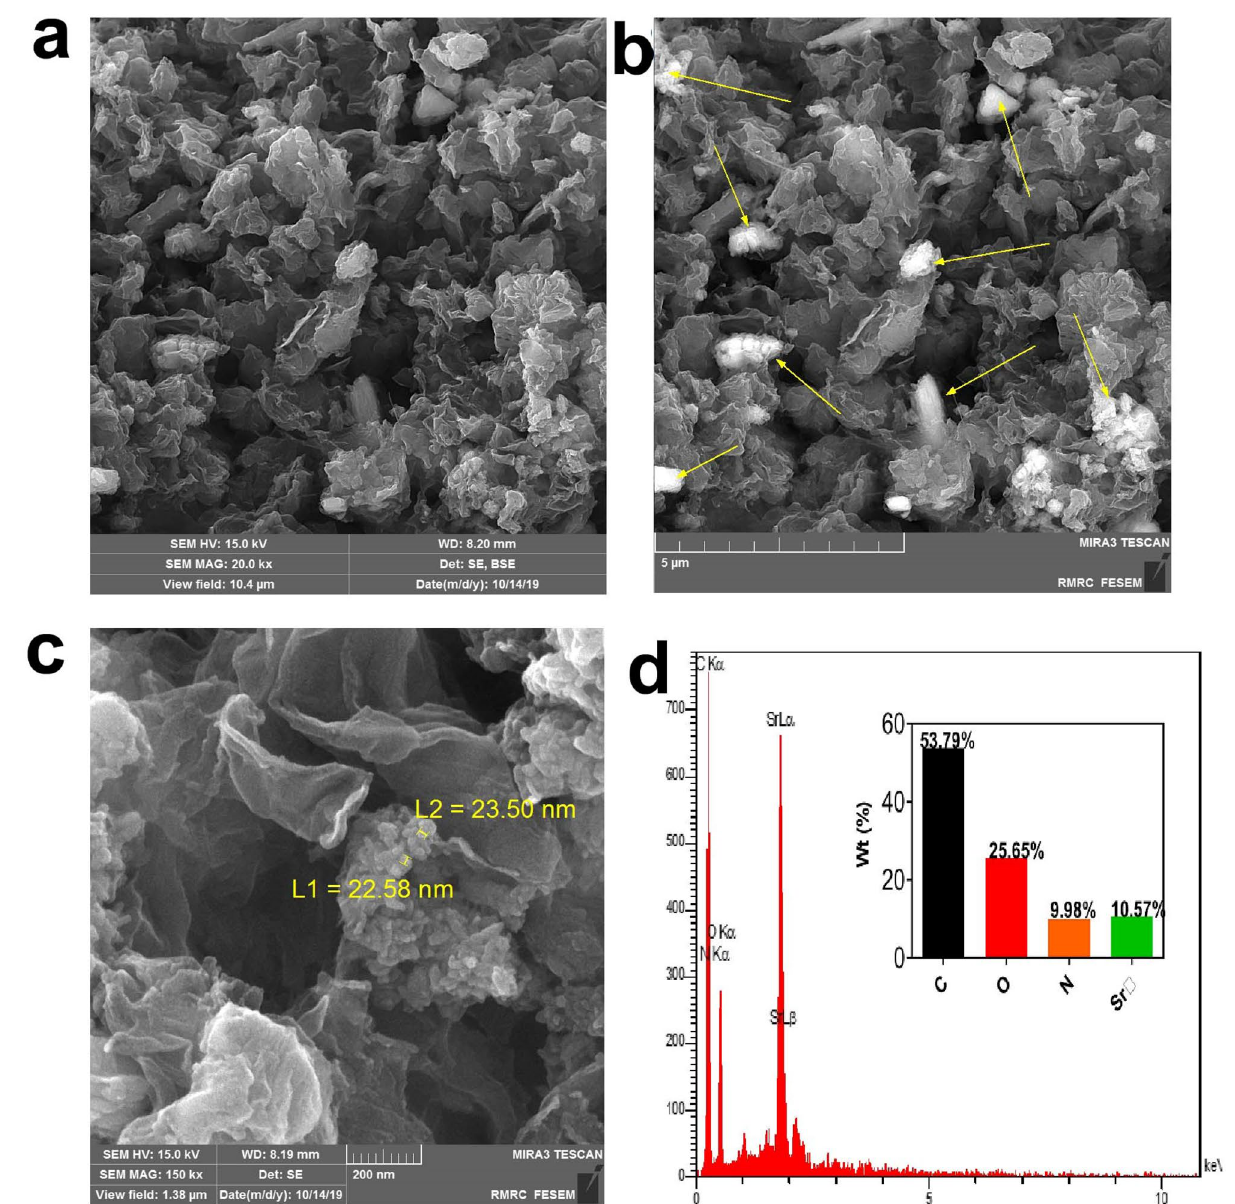
Figure 5. FESEM images of Sr-BSA-rGO nanosheets. ( a ) and ( c ) Secondary electron image. ( b ) Backscattered electron image (yellow arrows reveal Sr NPs). ( d ) EDS analysis of Sr-BSA-rGO